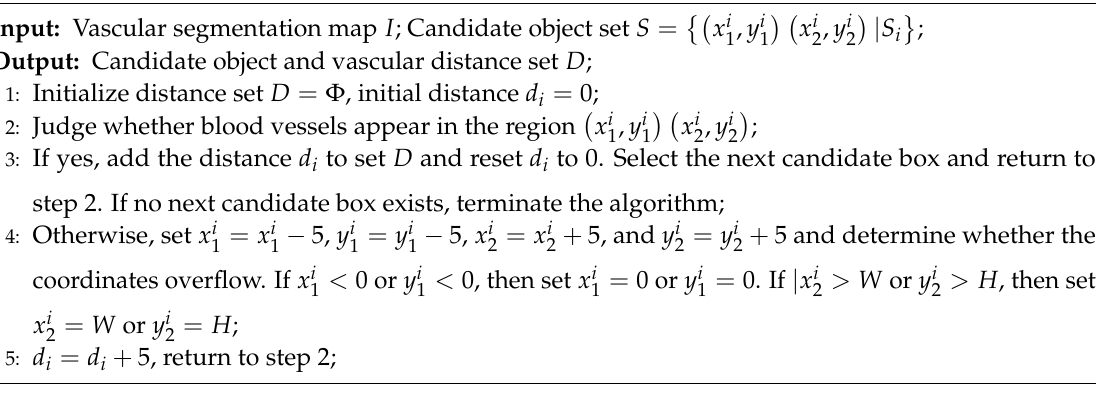
Algorithm 1 : Distance Calculation